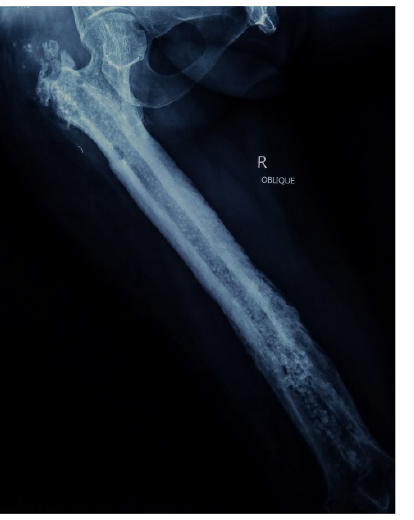
Figure 12. Post operative radiograph with SPHCS beads